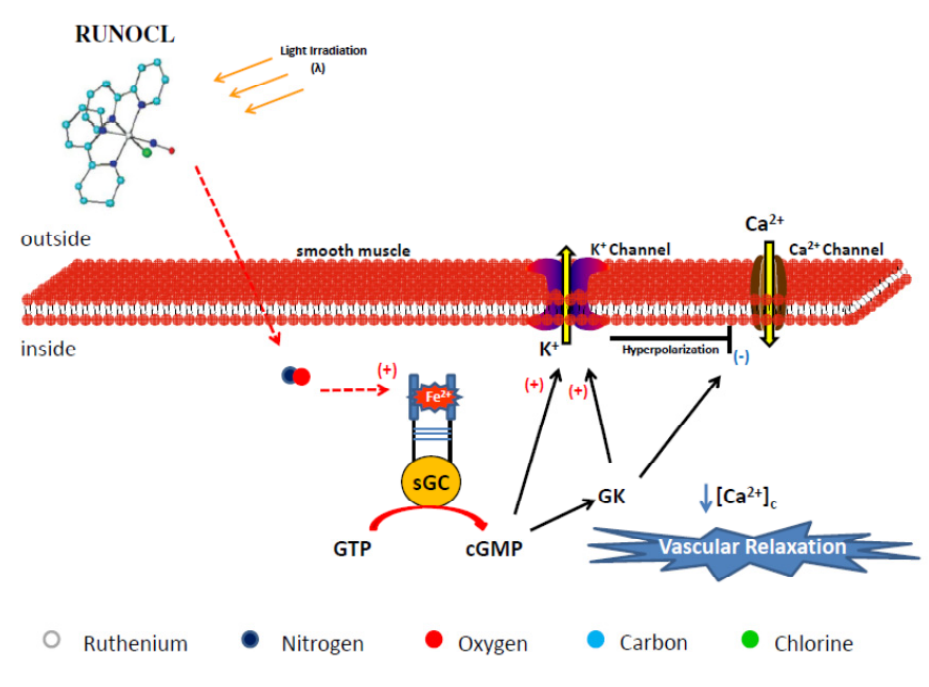
Figure 6. Proposed nitric oxide release and vasodilation mechanism elicited by cis- (NO)](PF ) (RUNOCL). The colored circles represent atoms in the chemical [RuCl(bpy) 2 6 structure. The hydrogen atom has been omitted in the structure. Legend: sGC = soluble guanylyl cyclase, GK = G Kinase Protein, Ca 2+ = calcium, K + = potassium, = cytosolic calcium [Ca 2+ ] c